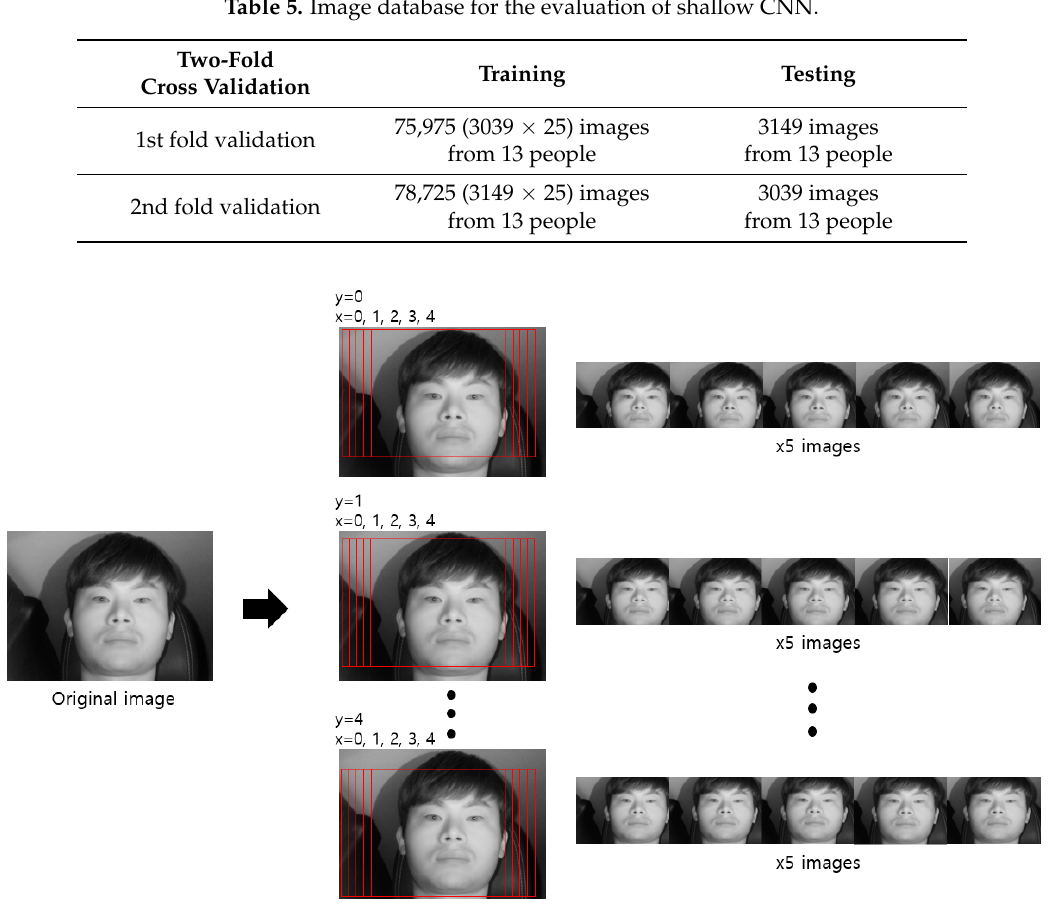
Figure 12. Examples of data augmentation through pixel shifting and cropping. Table 5. Image database for the evaluation of shallow CNN.